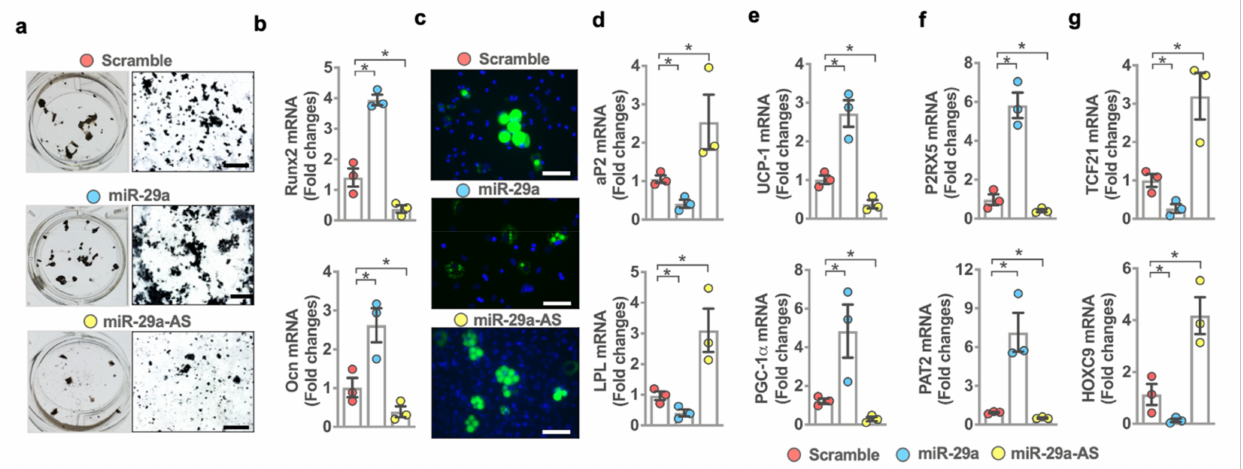
Figure 5. Effects of miR-29a mimics and antisense oligonucleotides on osteogenic differentiation and adipocyte formation of bone marrow mesenchymal stem cells. Forced miR-29a expression promoted mineralized matrix formation ( a ) (von Kossa staining; scale bar, 40 µ m) together with increased Runx2 and Ocn expression ( b ). miR-29a mimetics repressed fluorescence adipocyte formation ( c ) (fluorescence Nile red staining; scale bar, 8 µ m) and reduced aP2 and LPL expression ( d ). miR-29a mimetics promoted Ucp-1, Pgc-1 α ( e ), P2rx5, and Pat2 ( f ) expression in mesenchymal stem cells incubated in brown adipogenic medium, whereas Tcf21 and Hoxc9 ( g ) expression were repressed in cell cultures grown in white adipogenic medium. miR-29a antisense oligonucleotide (miR-29a-AS) inhibited osteogenesis and brown adipocyte marker expression but upregulated adipocyte formation together with upregulated white adipocyte marker expression. Mean ± S.E. is calculated from 3 experiments. * p < 0.05 upon ANOVA test and Bonferroni post hoc test. Scramble, scrambled control; miR-29a, miR-29a mimics; miR-29a-AS, miR-29a antisense